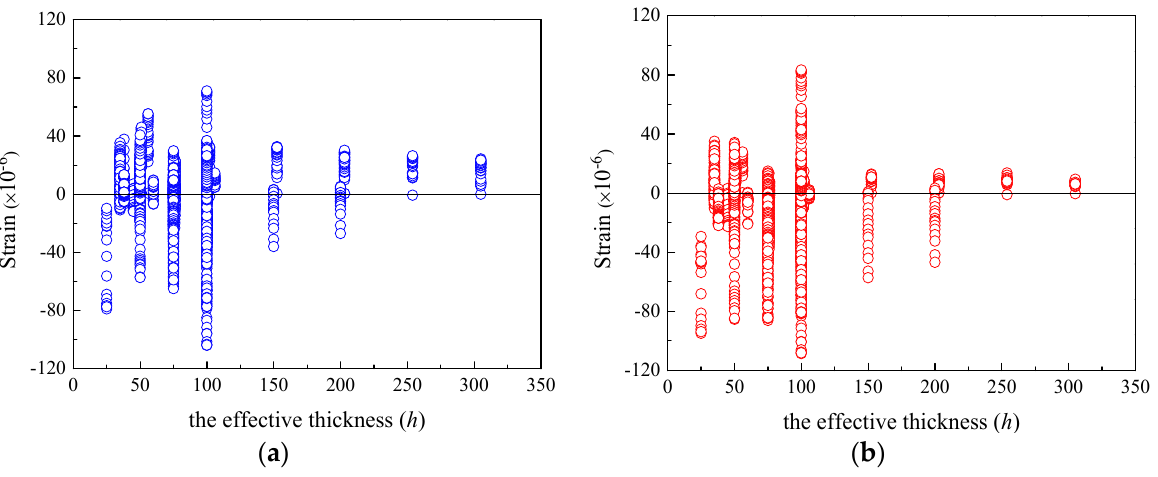
Figure 8. The residuals of creep compliance for CEB-FIP models versus h. ( a ) Residuals for CEB-FIP 1990 model. ( b ) Residuals for CEB-FIP 2010 model.